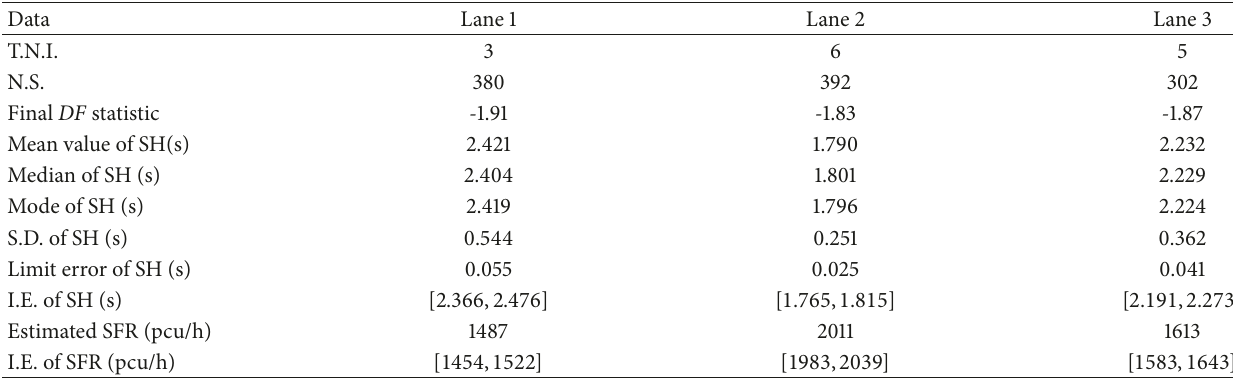
Table 5: Saturation headway estimations based on the 80% quantile for the three